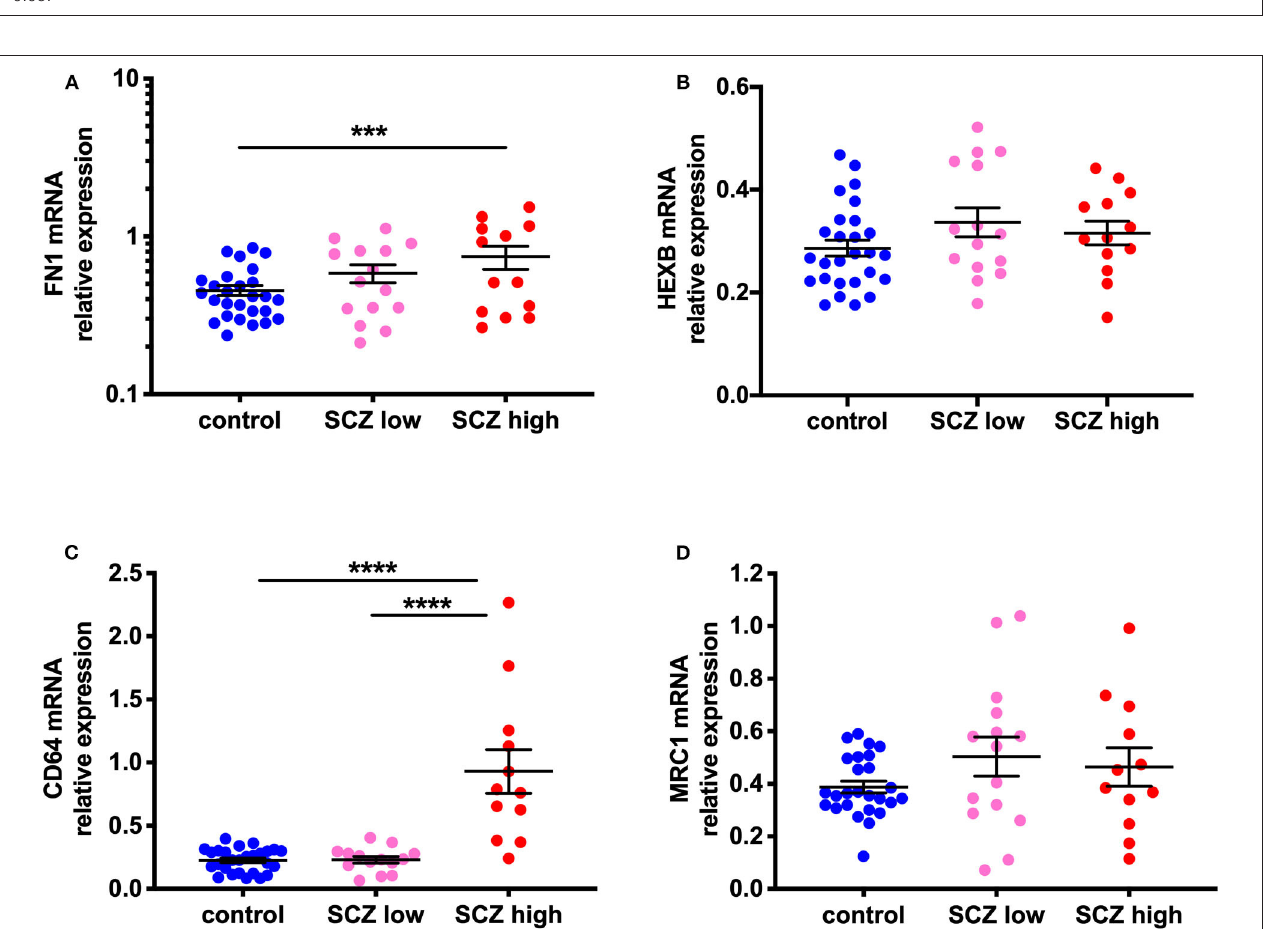
FIGURE 3 | (green) and CD163 (red) expression in cells in the midbrain. (a) shows IBA1 + /CD163- microglia (green arrowheads) in the midbrain. (b) Two IBA1 + /CD163 + cells (yellow arrowheads), one (left cell) with strong positivity for IBA1 and low expression of CD163, and one (right cell) with strong CD163 expression and low IBA1 expression. (c) Another double-labeled microglia/macrophage (yellow arrowhead). (d) An IBA1-/CD163 + putative macrophage (red arrowhead). (e) IBA1-/CD163 + (red arrowhead) and IBA1 + /CD163 + cells (yellow arrowhead). Nuclei are stained with DAPI (blue). Scale bars = 20 µ m. Data are mean ± SEM, * p < 0.05.